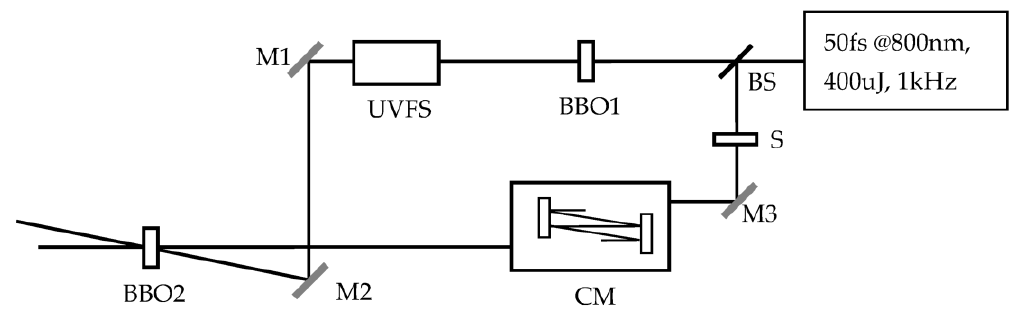
Figure 1. Experimental setup: BS, beam splitter (R = 20% at 800 nm); BBO1, 170- µ m BBO crystal (cut at an angle of 29.2 ◦ ); BBO2, 1-mm BBO crystal (cut at an angle of 31.5 ◦ ); UVFS, ultraviolet-grade fused silica; S, 2-mm-thick sapphire plate; M1 and M2, harmonic separators (HR at 400 nm and AR at 800 nm); M3, silver-coated mirror; CM, chirped mirror pair (Layertec GmbH, model 103189).